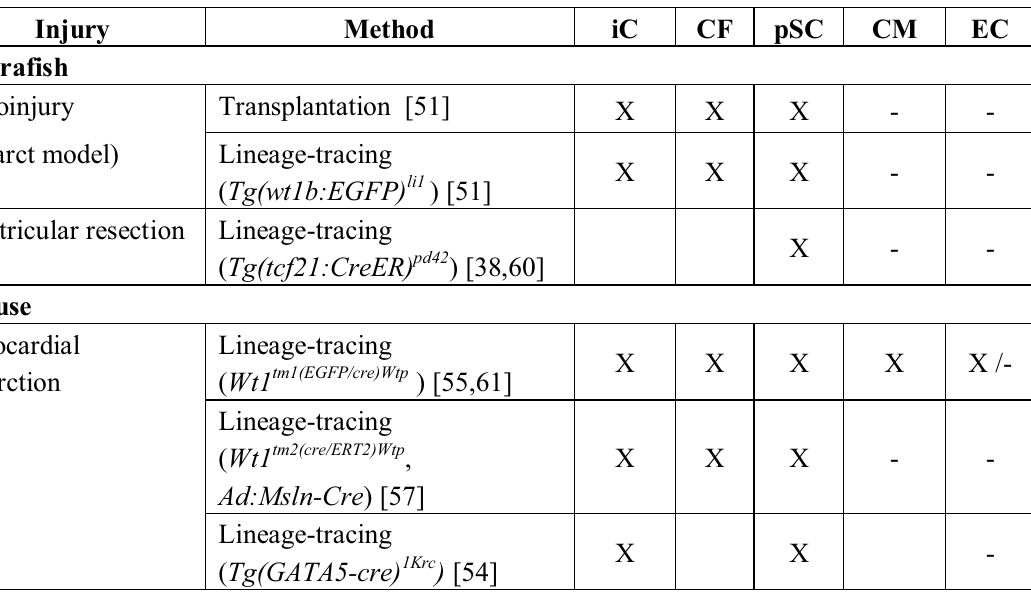
Table 2. Fate of epicardial cells after